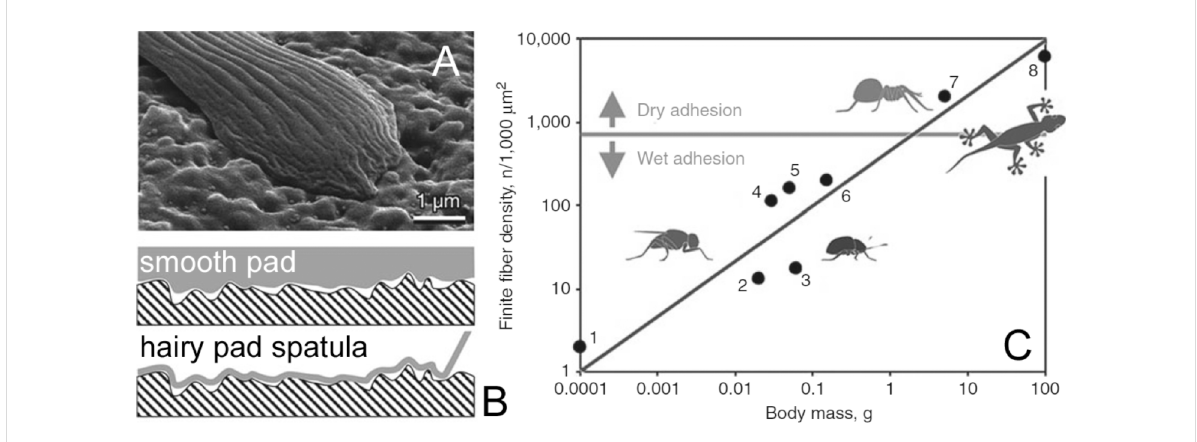
Figure 6: Compliancy of adhesive structures to the substrate (A,B) and contact splitting (C). (A) Contact of a spatula of the beetle Gastrophysa viridula with a surface with microscale roughness. (B) Soft smooth pad requires additional load to form an adhesive contact (B, upper image), where- as the adhesion interaction pulls the elastic thin film of the spatula into a complete contact with the rough substrate surface (Figure 6A and 6B are from [241] and were adapted by permission from Springer Nature from “Biological fibrillar adhesives: functional principles and biomimetic applications. In: Handbook of Adhesion Technology” by S. N. Gorb, Copyright 2011 Springer Nature. This content is not subject to CC BY 4.0). (C) Dependence of the contact density of terminal contacts on the body mass in fibrillar pad systems in representatives of diverse animal groups: 1, 2, 4, 5, flies; 3 beetle; 6 bug; 7 spider; 8 Gekkonid lizard (Figure 6C is from [247] and was adapted by permission from Springer Nature from “Biological Micro– and Nanotri- bology: Nature’s Solutions” by M. Scherge and S. N. Gorb, Copyright 2001 Springer Nature. This content is not subject to CC BY 4.0). The systems, situated above the solid horizontal line, preferably rely on van der Waals forces (dry adhesion), whereas the rest rely mostly on capillary and viscous forces (wet